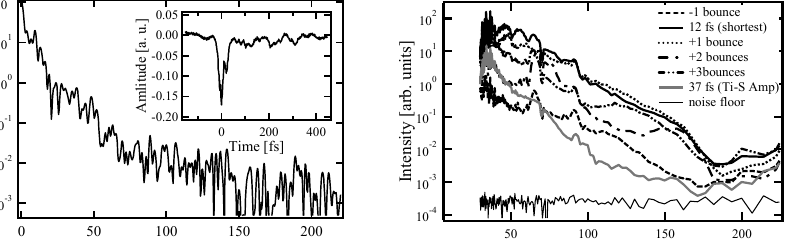
Fig. 2 Fourier transformed spectrum of the infrared pulse observed by electro-optic sampling with 20-µm thick GaSe crystal. Inset shows the temporal electric field profile.